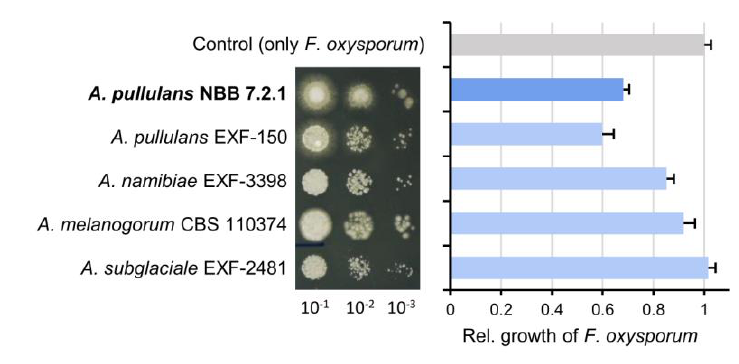
FIGURE 1: Comparison of five Aureobasidium species with respect to growth on agar plates and antagonis- tic activity. The different Aureobasidium species grow at comparable rates in spot assays, but show differ- ences in antagonistic activity against the plant patho- genic fungus F. oxysporum NRRL 26381/CL57 . Over- night cultures of the five strains were diluted to OD 600 =0.1 and three serial 1:10 dilutions were spotted on PDB agar (left). Competition assays were per- formed with highly diluted Aureobasidium samples (OD 600 = 0.001) and the area of F. oxysporum growth was measured to reveal the differences in their antag- onistic activity. The relative growth of F. oxysporum was reduced in competition with both A. pullulans strains (NBB 7.2.1 and EXF-150), while the other Aure- obasidium species were less